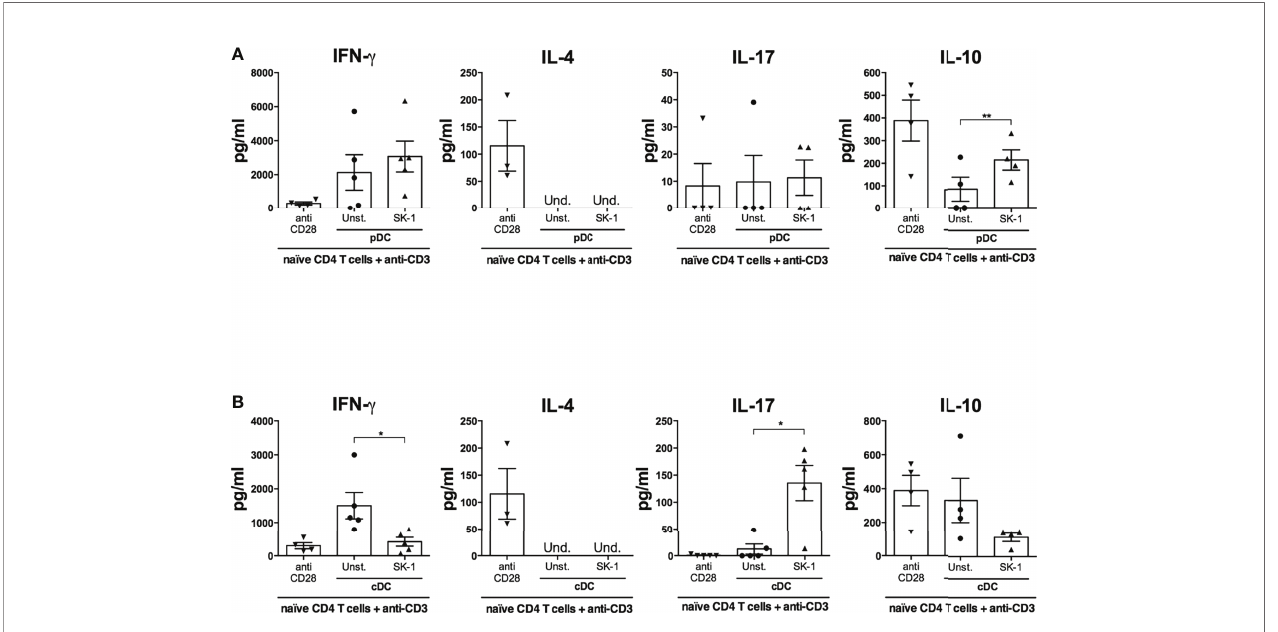
FIGURE 6 | Plasmacytoid dendritic cells (pDCs) and conventional dendritic cells (cDCs) primed with SK-1 induce IL-10- and IL-17-producing CD4 T cells, respectively. Human naïve CD4 T cells were cultured in the presence of anti-CD3/CD28 beads or placed in a co-culture for 5 days with unstimulated or SK-1-primed pDCs or cDCs in the presence of anti-CD3. After 5 days, the cells were re-stimulated with anti-CD3 (co-culture) or anti-CD3/CD28 beads (CD4 T cells alone). Supernatants were collected after 24 h of re-stimulation, and the levels of IFN- g , IL-4, IL-17, and IL-10 in co-cultures with pDCs (A) and cDCs (B) were measured by ELISA. The graphs show the mean ± SEM of four or fi ve independent experiments, each from different donors. Paired Student ’ s t -test was used to compare unstimulated and stimulated DCs (*= p -value ≤ 0.05; **= p -value ≤